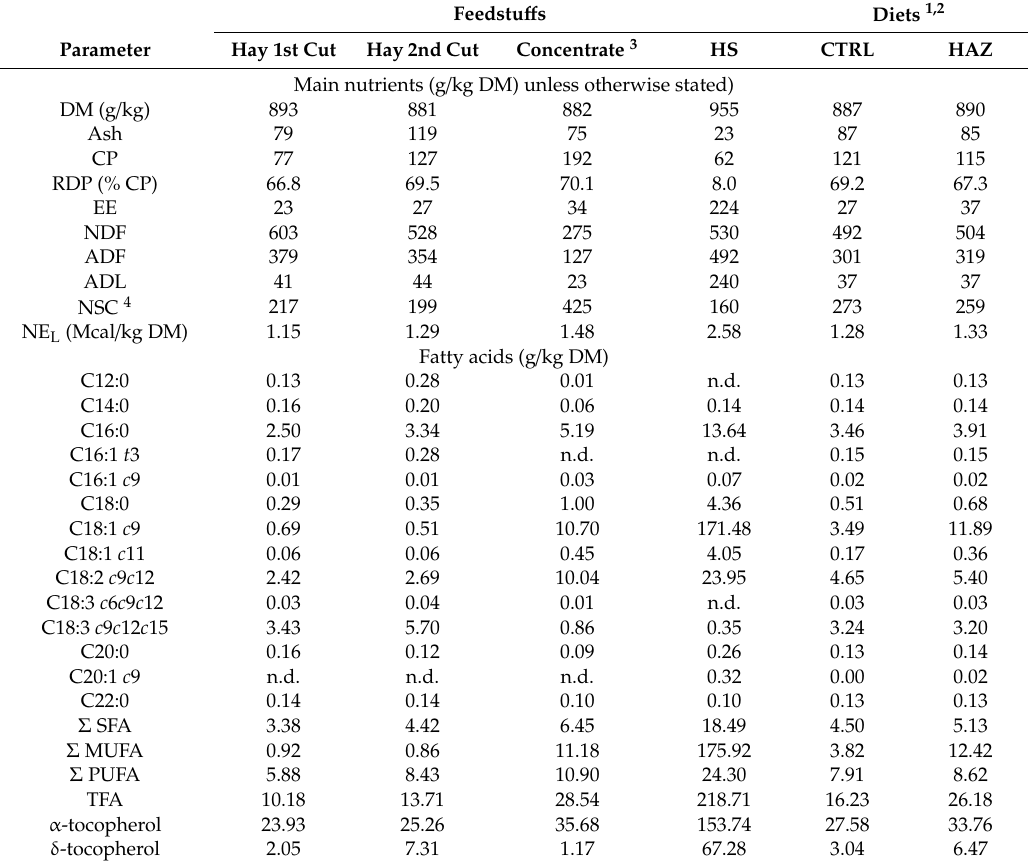
Table 1. Proximate composition, fatty acid profile, and tocopherols content of the experimental feedstu ff s and